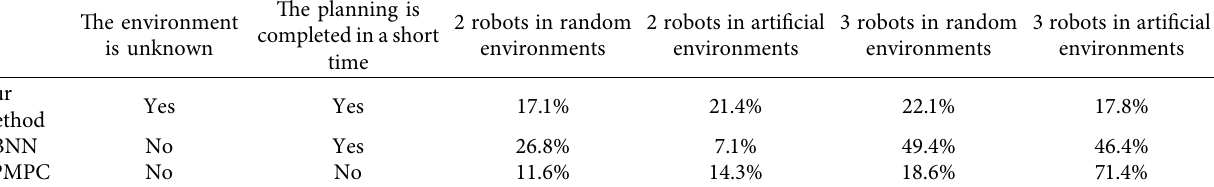
Table 5: The average repetition rates in comparison